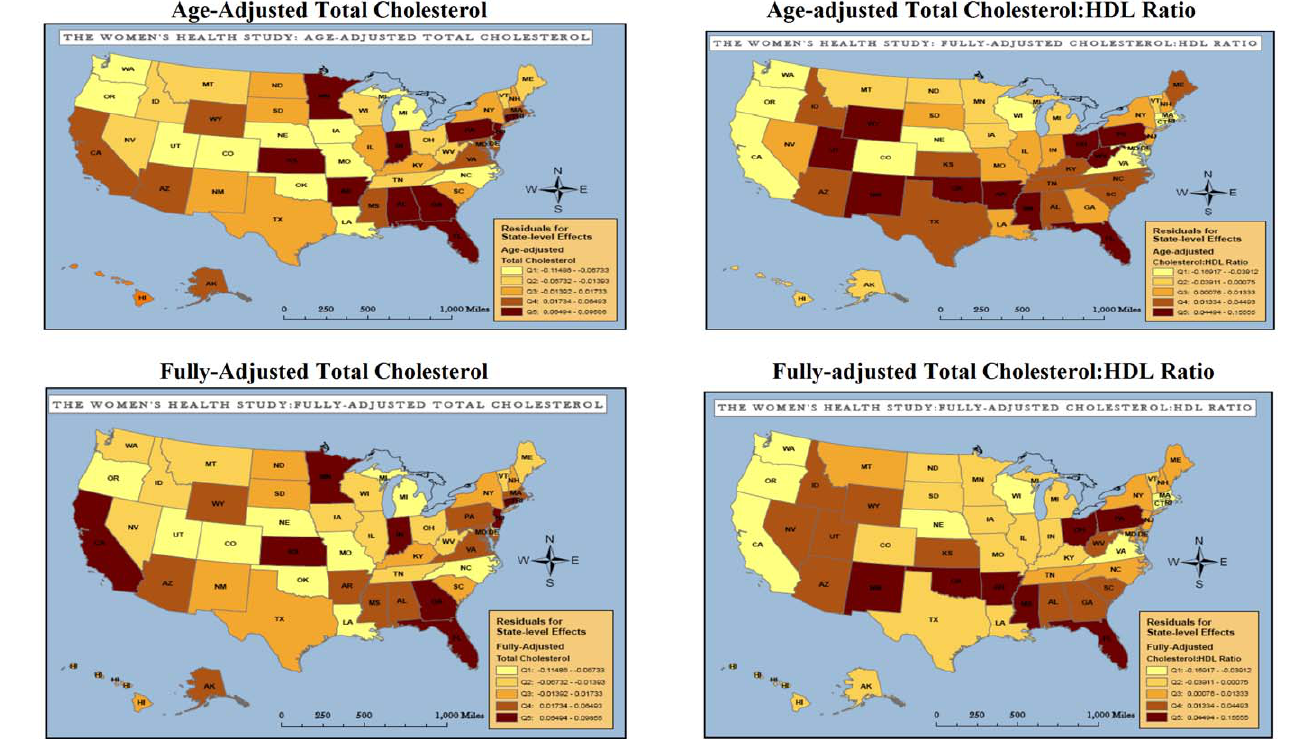
Figure 2. State-level Variation in Cholesterol in the Women’s Health Study. Source: Women’s Health Study Participants. Abbreviations: Q1: Lowest quintile of risk; Q5: Highest quintile of risk. Fully-adjusted models include: age, race/ethnicity, obese/overweight status, systolic blood pressure, diabetes status, smoking, exercise, caloric intake.